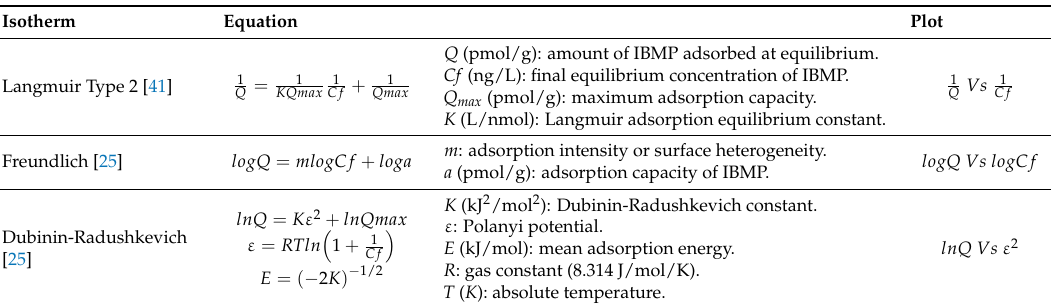
Table 1. List of linear form adsorption isotherm models.